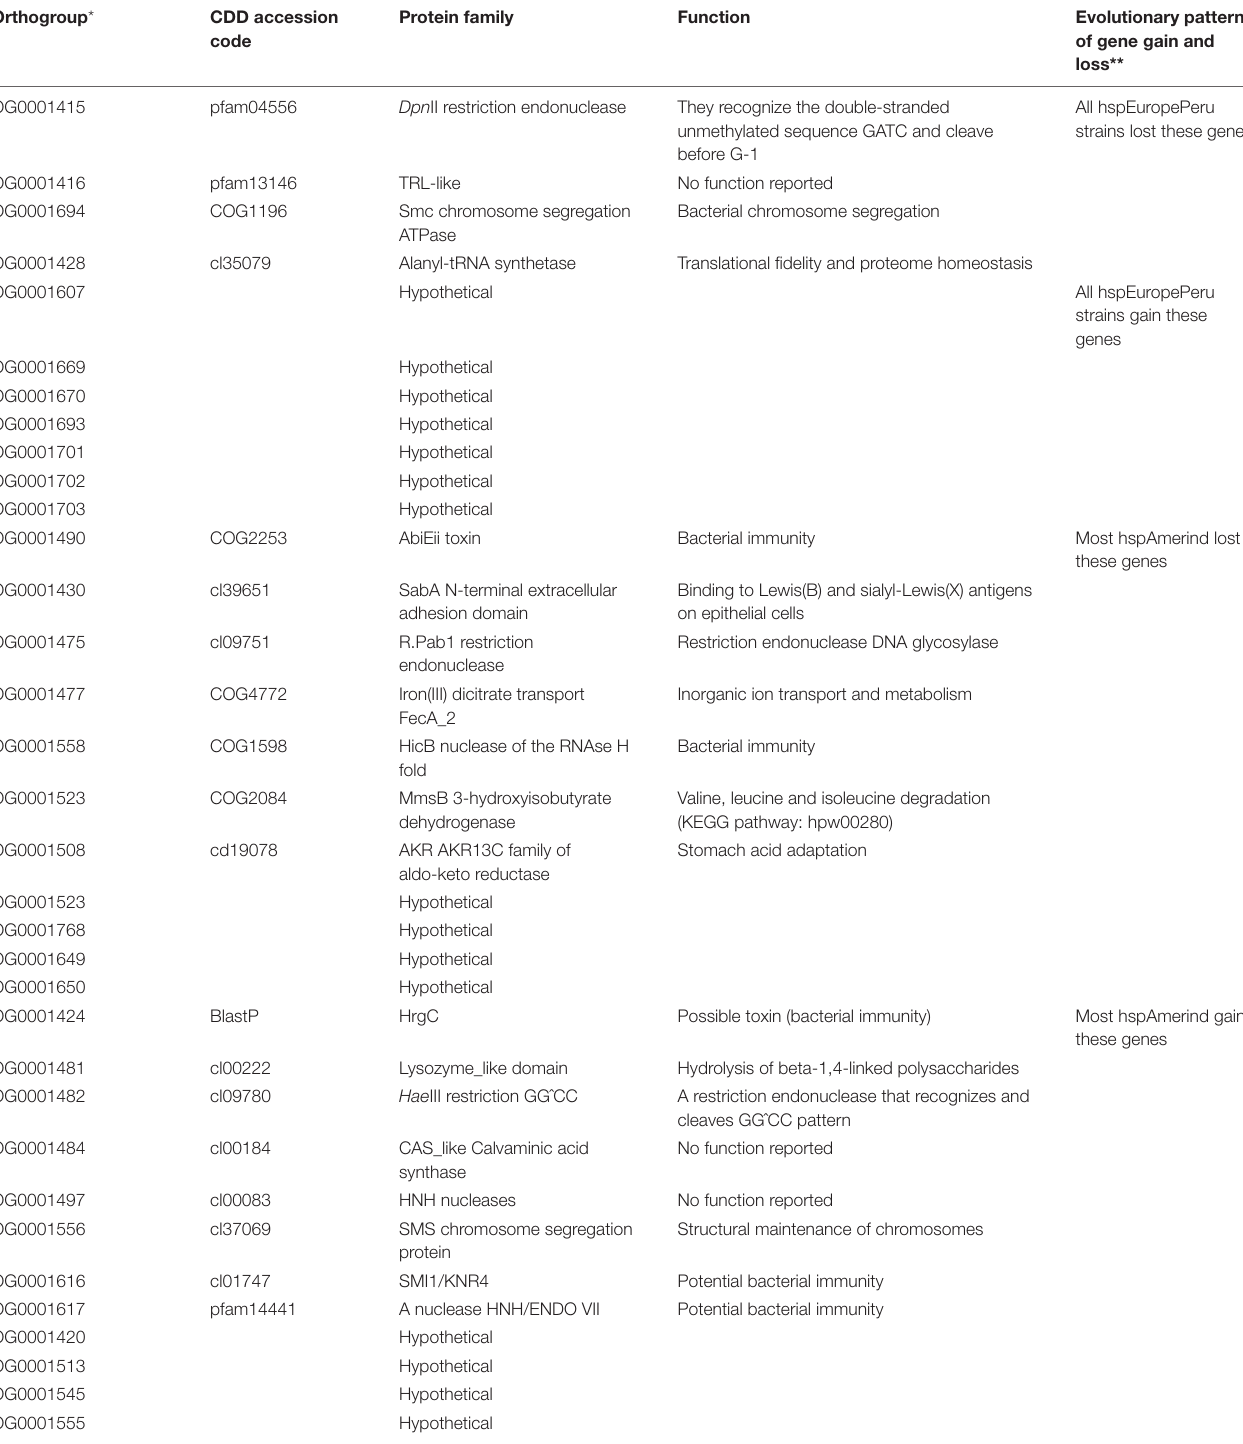
TABLE 1 | Gain and loss patterns of orthogroup in hspAmerind and hspEuropePeru strains. Orthogroup